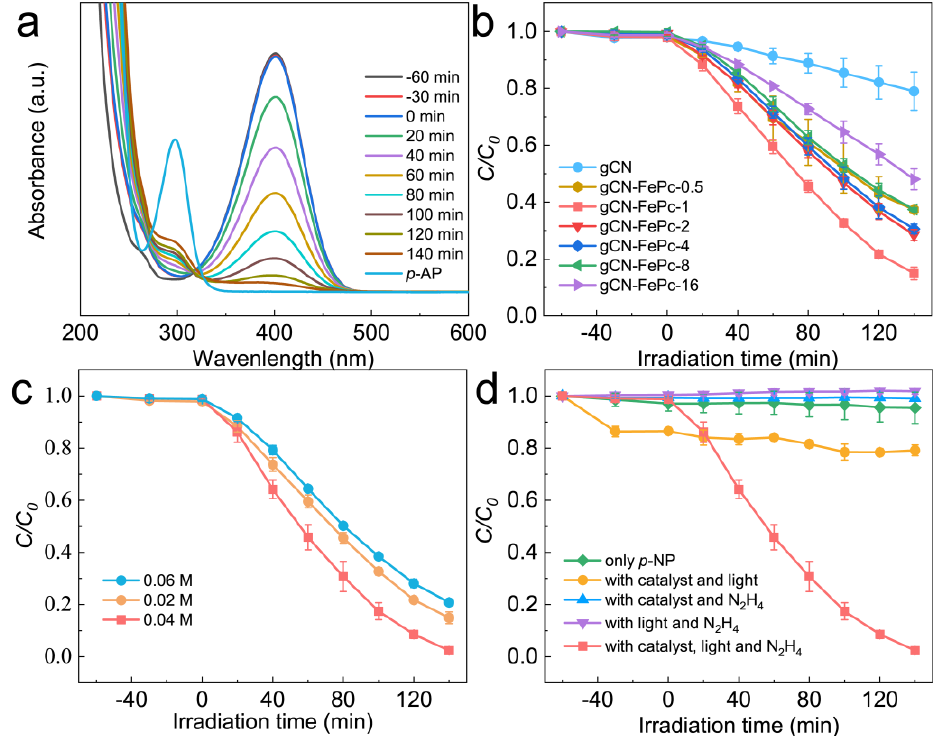
Figure 6. UV-vis absorption spectra of p -NP solution after photocatalytic reaction by the gCN-FePc-1 from 0-140 min ( a ); comparison of photocatalytic performance for p -NP reduction by various photocatalysts ( b ); effect of N 2 H 4 dosage on photocatalytic reduction activity of p -NP by gCN-FePc-1 ( c ); photocatalytic reduction performance of p -NP under various experimental conditions ( d ). The experimental data in Figure 6 ( b – d ) are based on three repeated experiments.